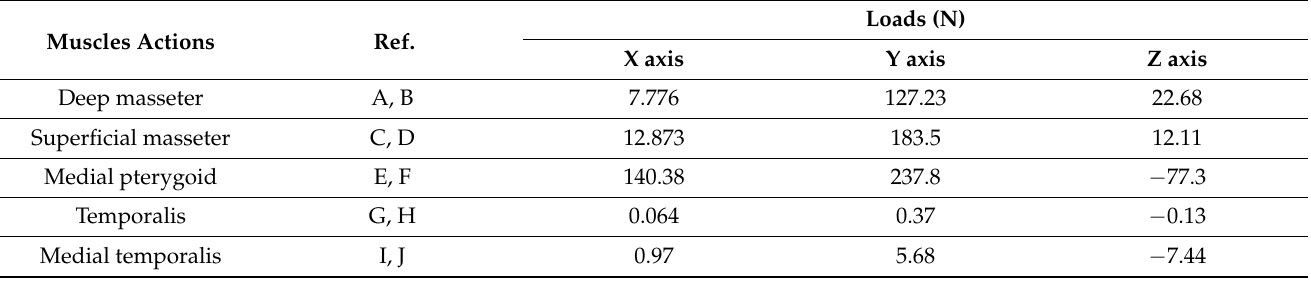
Table 2. Forces and acting direction of the major muscles applied onto the mandible for occlusion in the finite element analysis [28].